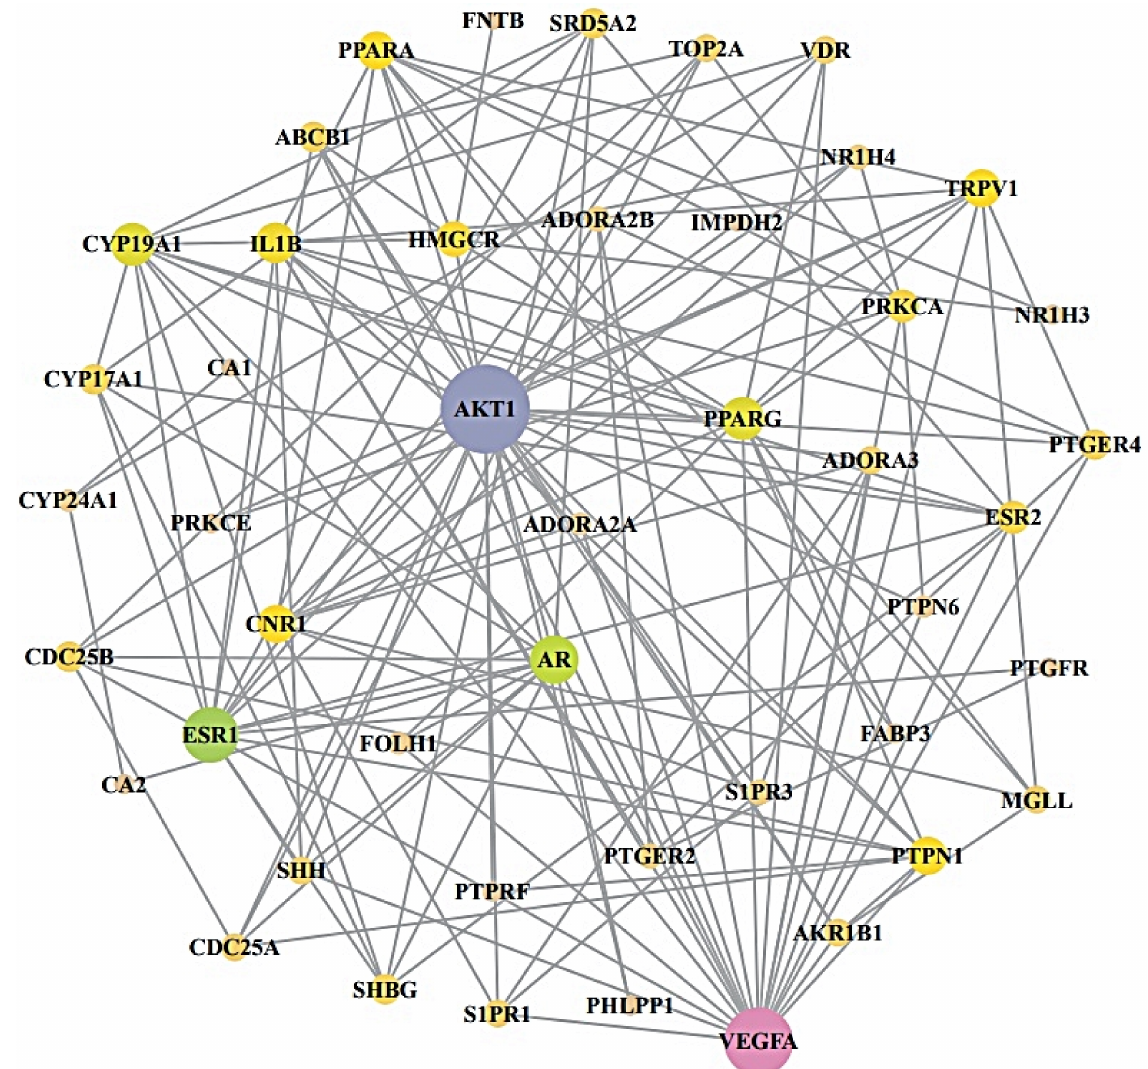
Figure 4. PPI networks (46 nodes, 145 edges). The size of circles represents the degree of